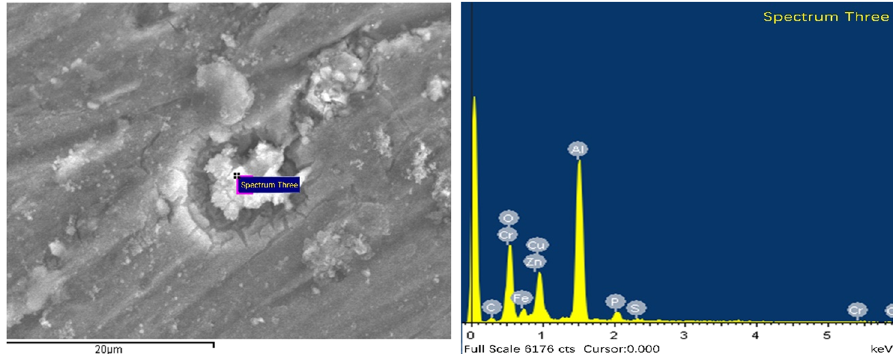
Figure 19: EDS analysis of the aluminium alloy under the corroded of the saturated Ca ( OH ) 2 solution.